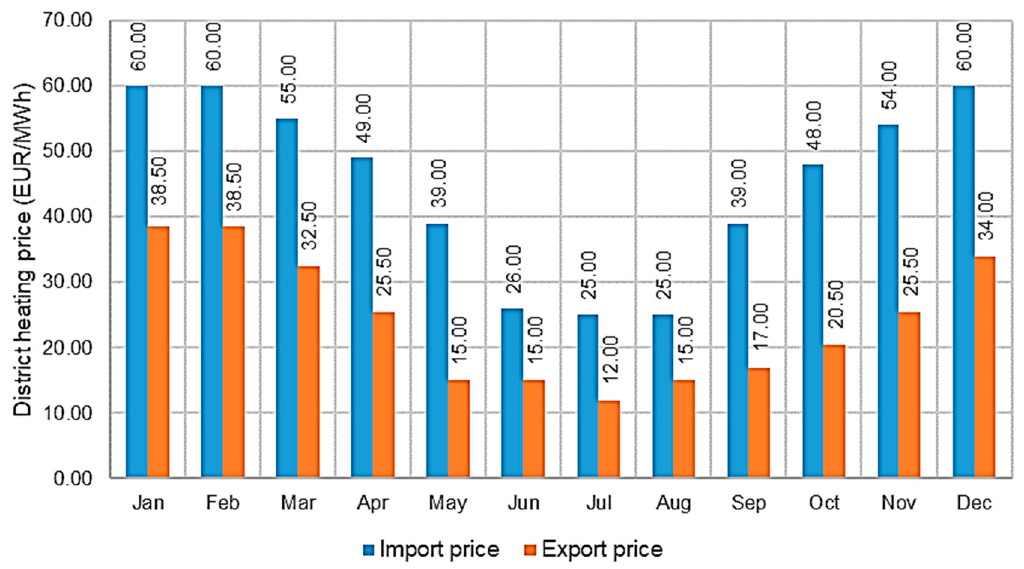
Figure 6. District heating import and export prices in Espoo, Finland [4,5].